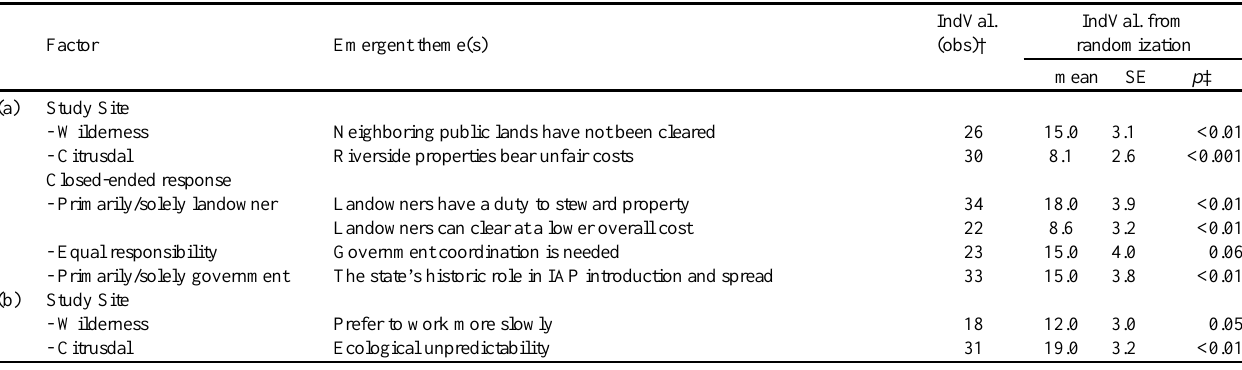
Table 7 . Results from Dufrêne-Legendre Indicator Value Analysis of associations between landowner study site, landowner responses to closed-ended questionnaire items, and emergent themes regarding (a) landowner and government responsibility for clearing invasive alien plants (IAPs); or (b) the quantity and duration of financial assistance proposed in WfW’s approach. Factor Emergent theme(s)